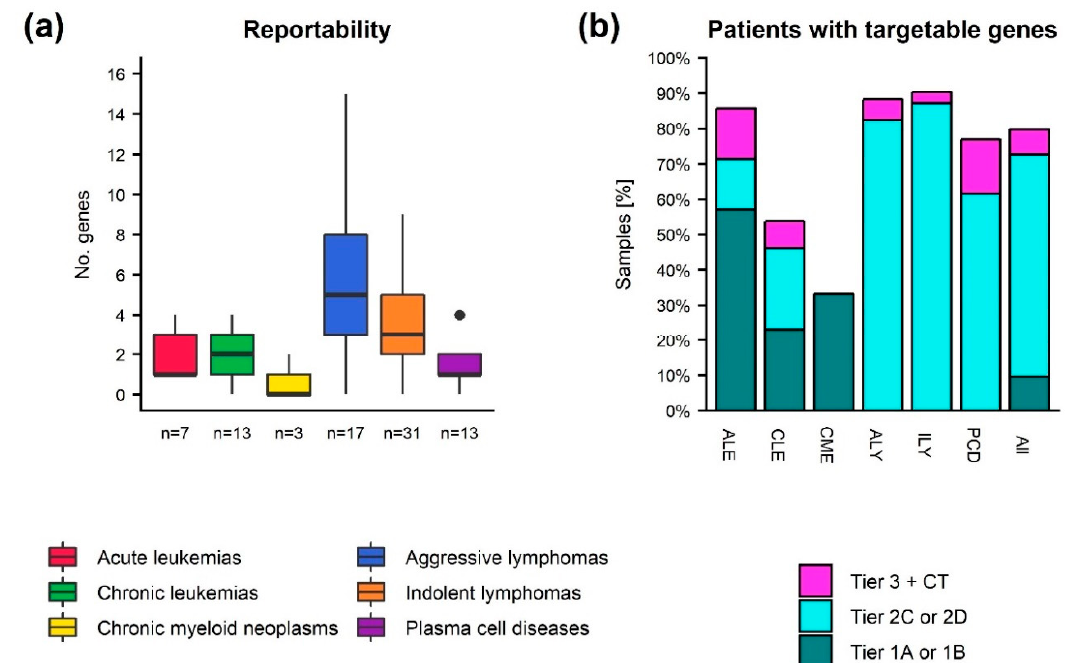
Figure 4. Reportable somatic variants in hematological malignancies. ( a ) Number of genes with detected somatic variants reported per sample after manual verification. ( b ) Percentage of patients (grouped by diagnosis or overall) with at least one variant having strong clinical relevance (tier 1A and 1B), potential clinical relevance (tier 2C and 2D), or at most having unknown clinical significance, but with an associated clinical trial (tier 3 + CT). If multiple samples were sequenced for a patient, only the latest is represented in the figure. The single sample from a patient with CLL with more than 5000 retained variants was not subjected to variant interpretation. ALE: Acute leukemia, CLE: Chronic leukemia, CME: Chronic Myeloid Neoplasms, ALY: Aggressive Lymphomas, ILY: Indolent Lymphomas, PCD: Plasma Cell Diseases.